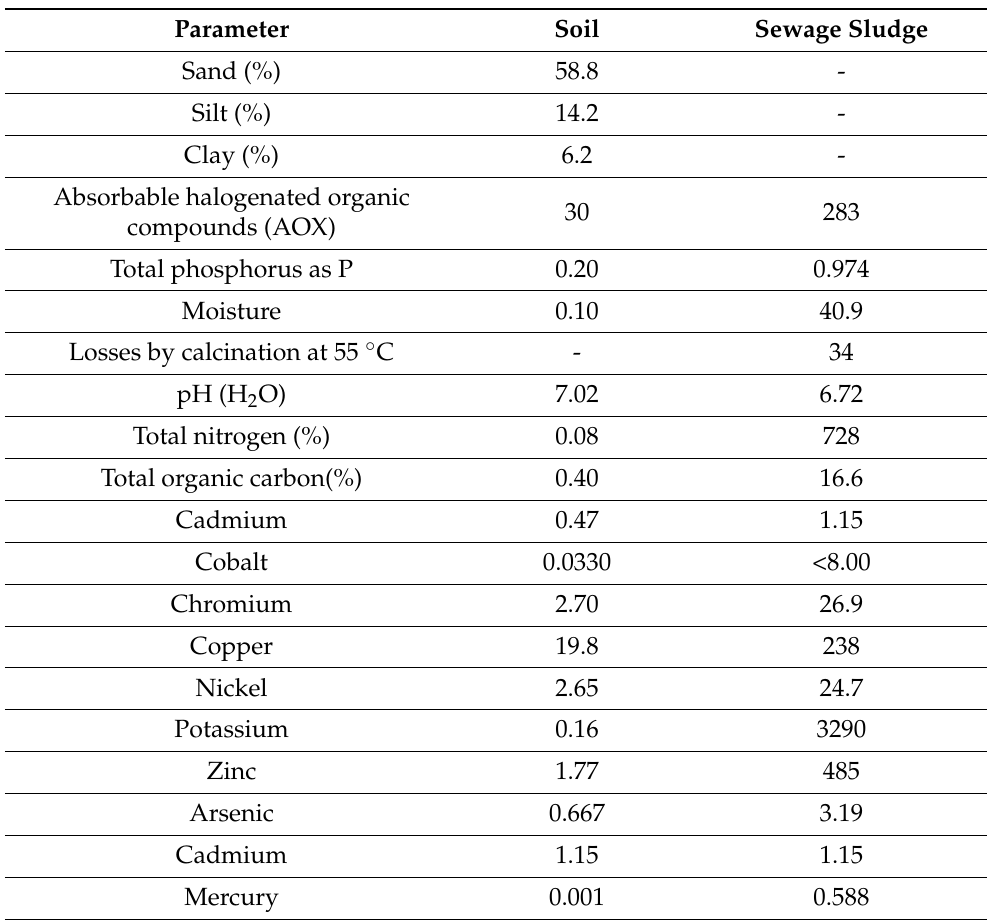
Table 1. The physico-chemical composition of the sludge, resulting from the purification of urban sewage waste water from the Municipality of Alexandria, Teleorman and of the soil from the perimeter studied. Parameter Soil Sewage Sludge Sand (%) 58.8 - Silt (%) 14.2 - Clay (%) 6.2